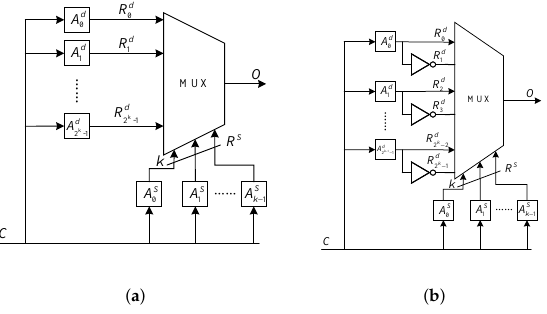
Figure 1. The structure of ( a ) ( n , k ) -MPUF, ( b ) ( n , k ) -cMPUF.